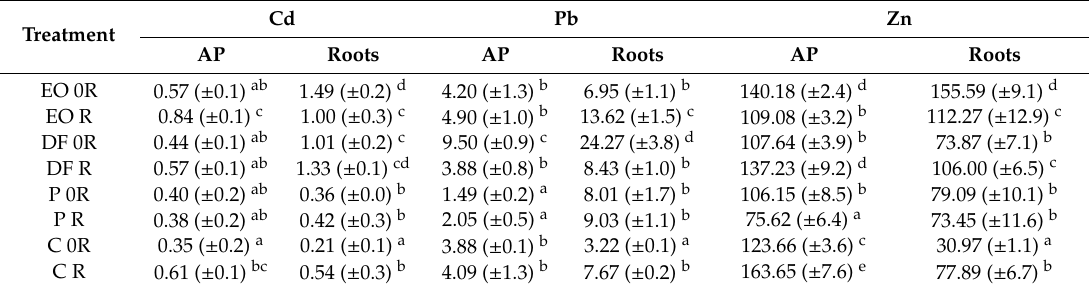
Table 5. The e ff ect of petroleum-derived substances and bioremediation on the content of cadmium, lead and zinc in the aboveground parts (AP) and roots of Vicia faba L. (mg kg − 1 ). Treatment